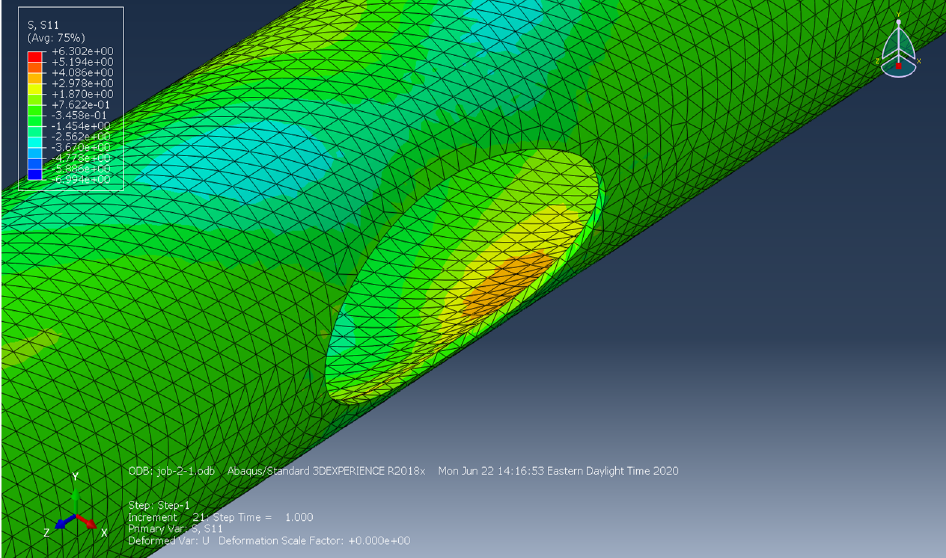
Figure 17. Aspect ratio 2-1 in transverse (X) direction.